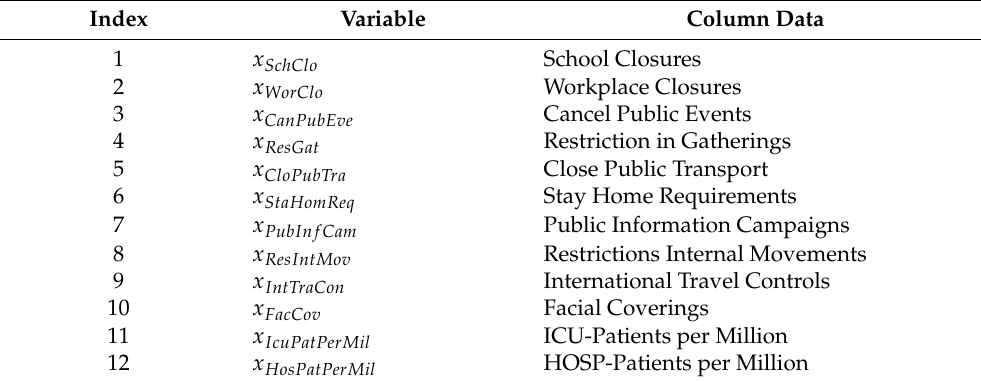
Table 2. Description of input variables into the deep learning model hospitalizations and icu admissions.